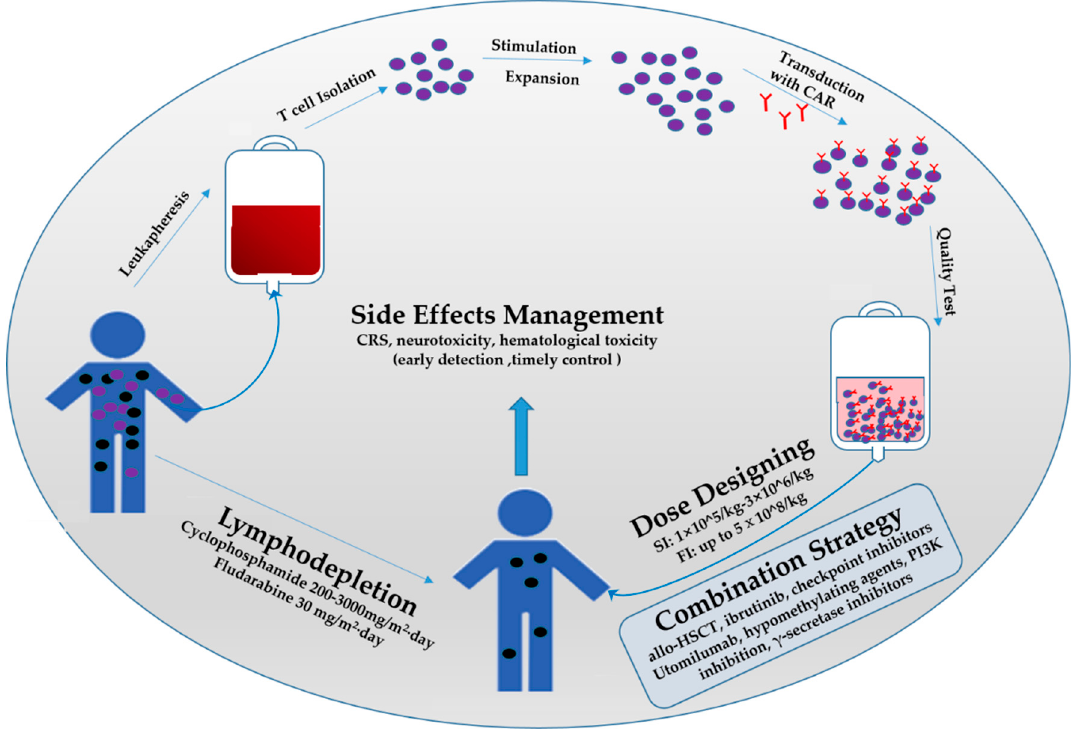
Figure 2. Process and clinical application strategies of CAR T-cell therapy. The preparation of CAR T-cells contains leukapheresis, T cell isolation, and stimulation and expansion in vitro; then, T cells are transduced with the CAR structure targeting a specific antigen. Then, the qualified CAR T-cells are infused into the patient via intravenous injection. In the clinical stage, lymphodepletion, dose designing of CAR T-cells and side effects management must be seriously considered during clinical treatment. If necessary, combination strategies should be taken into consideration. SI: Single Infu- sion; FI: Fractionated Infusion.